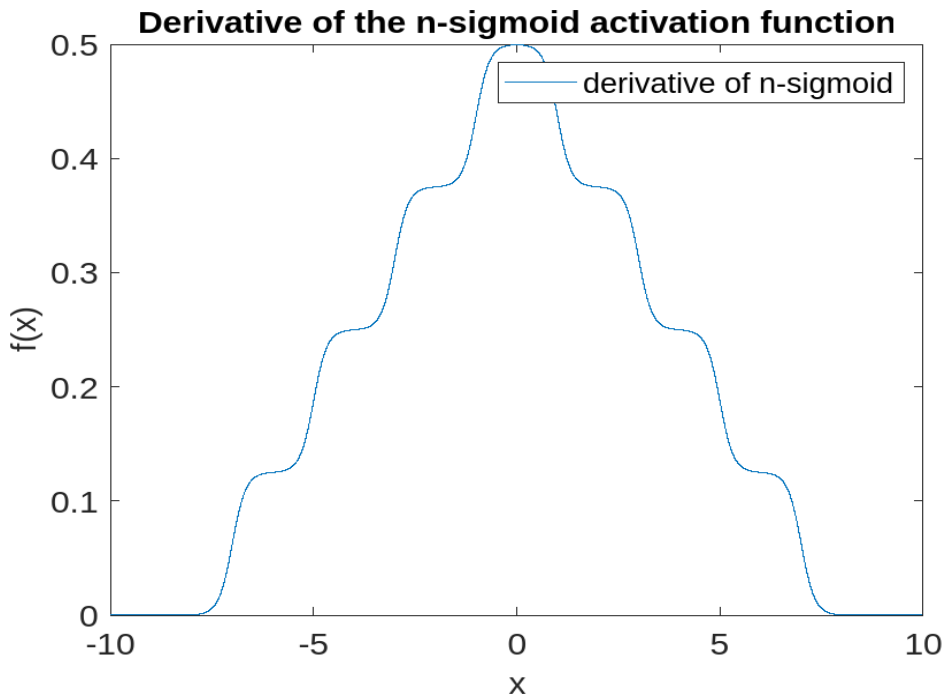
Figure 3. The n-sigmoid activation function.